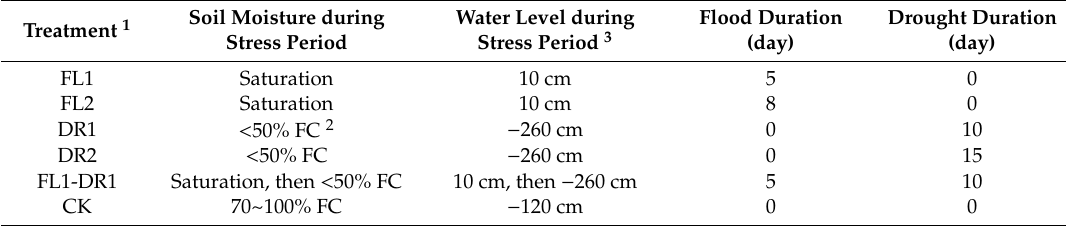
Table 1. The flood, drought, flood, followed by drought, and control treatments. Treatment 1